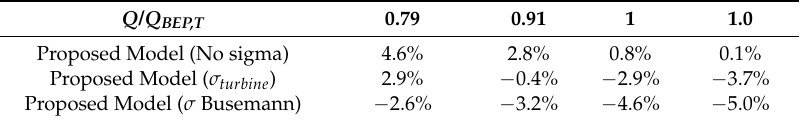
Figure 28. Comparison of different slip factor definitions in the 1-D curve prediction model (i.e., σ turbine , σ proposed by Busemann and σ = 1) with the experimental curve. Table 5. Comparison of different slip factor definition applied to the 1-D proposed prediction model for PaT characteristic curve in terms of head prediction errors.